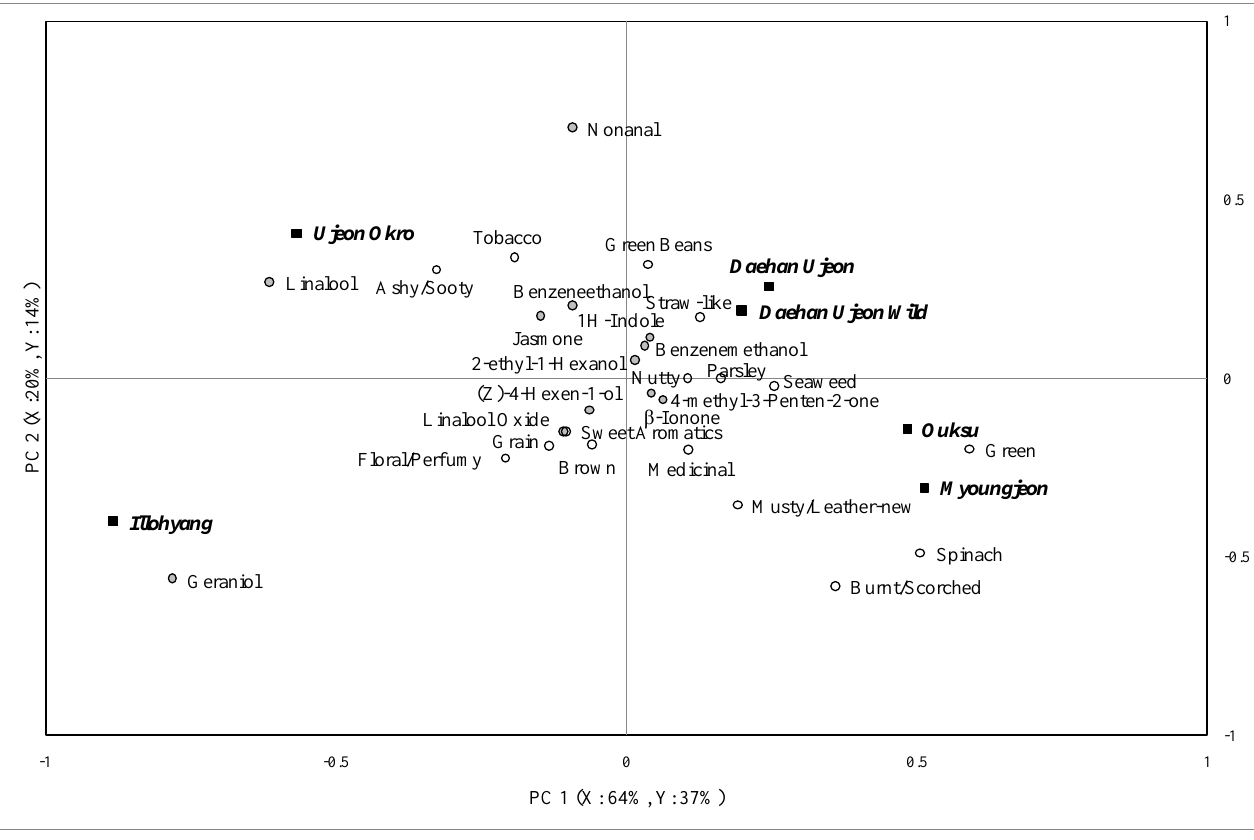
Figure 3. Partial least square regression analysis of descriptive sensory and gas chromatography data for the second brew of green tea